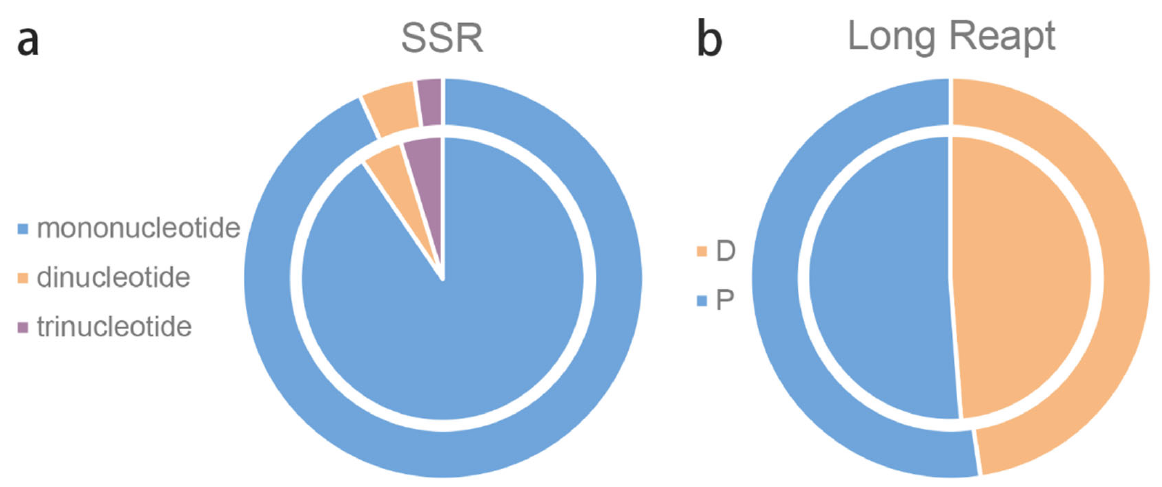
Figure 2. SSRs and long repeats in O. taihangensis and O. longilobus. ( a ) Type of SSRs detected in two species. ( b ) Long repeats classification of two species. The outer circle is O. taihangensis , and the inner circle is O. longilobus.